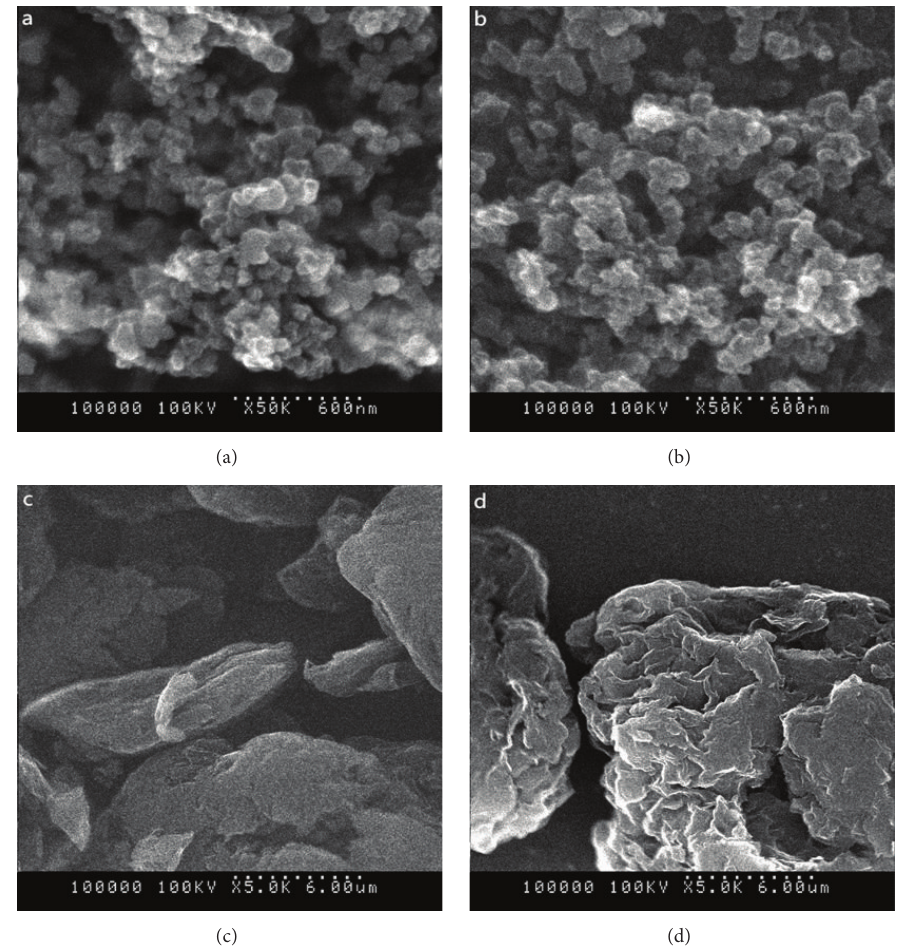
Figure 5: Representative SEM images of different adsorbents. (a) CB (scale bar is 600 nm), (b) OCB (scale bar is 600 nm), (c) bentonite (scale bar is 6 𝜇 m), and (d) organic bentonite (scale bar is 6 𝜇